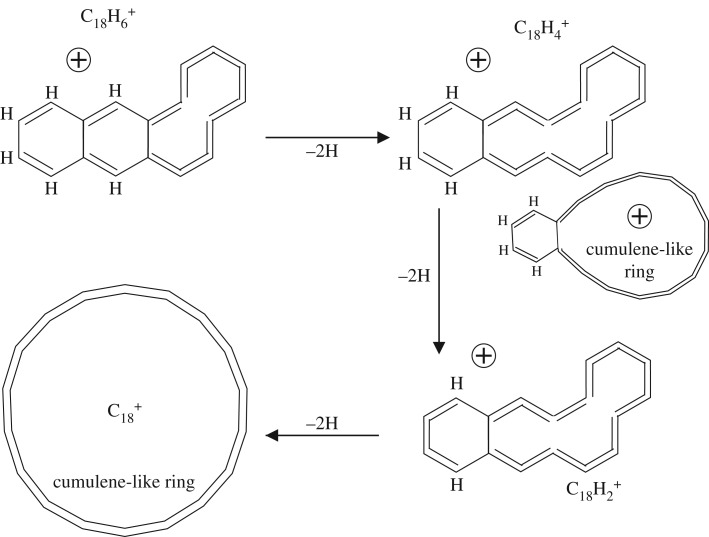
A proposed pathway for the dehydrogenation of the C18H 6+ cation to C 24+. The double ring structure in the upper and middle right shows the most probably bicyclic form of the C18H 4+ cation, i.e. an ortho-substituted sixfold ring with a 12-carbon atom cumulene-type ring [13–15].